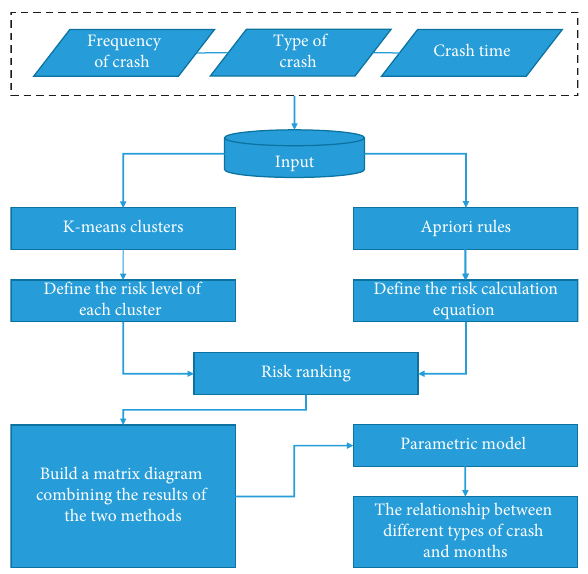
Figure 2: The framework of the combined